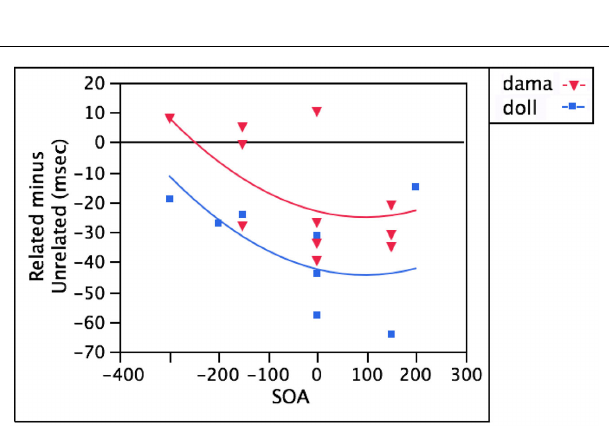
FIGURE 4 | Stronger phonological interference for target language